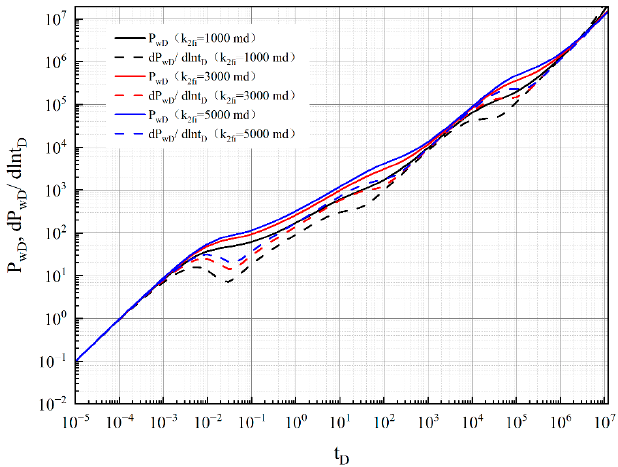
Figure 14. The effect of FSRV fracture permeability on the pressure response.